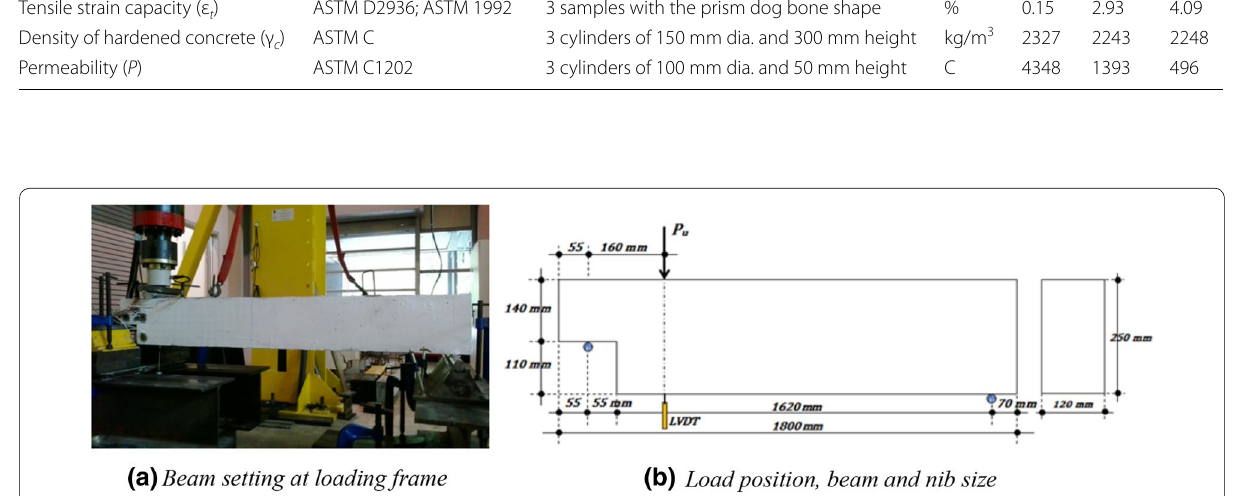
Fig. 4 Experimental setup of DEB